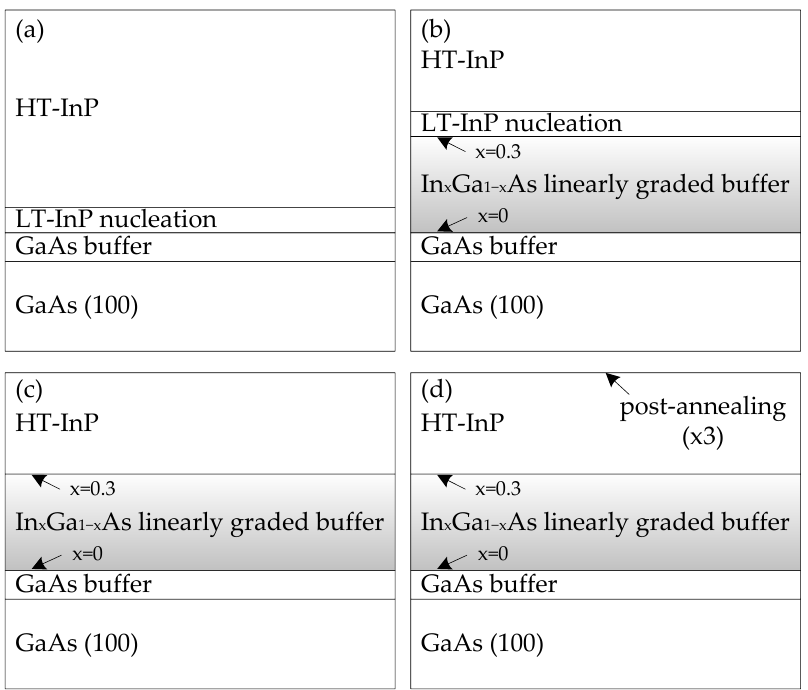
Figure 1. Schematic structure of an InP/GaAs virtual substrate prepared using ( a ) a two-step method; ( b ) an InGaAs linearly graded buffer combined with the two-step method; ( c ) the direct growth of HT-InP on the InGaAs linearly graded buffer; ( d ) the method “c” with additional three cycles of post-annealing.